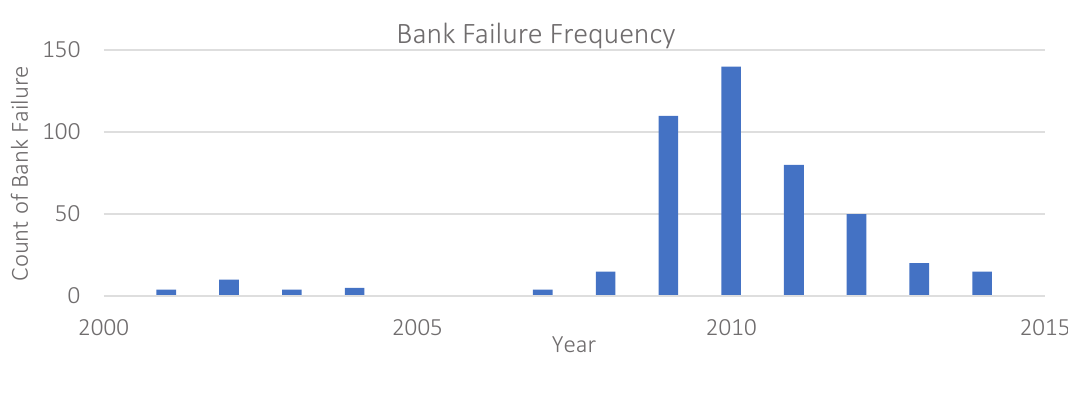
Figure 1. The distribution of the occurrence of bank failures from 2001 to Table 1. Definitions of variables